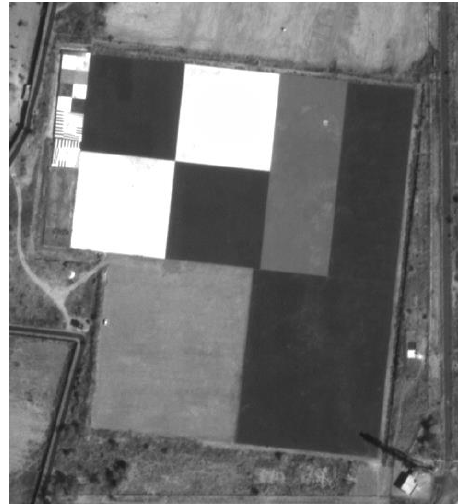
Figure 15. High contrast (Black & White) edges in panchromatic imagery of high resolution sensor for MTF